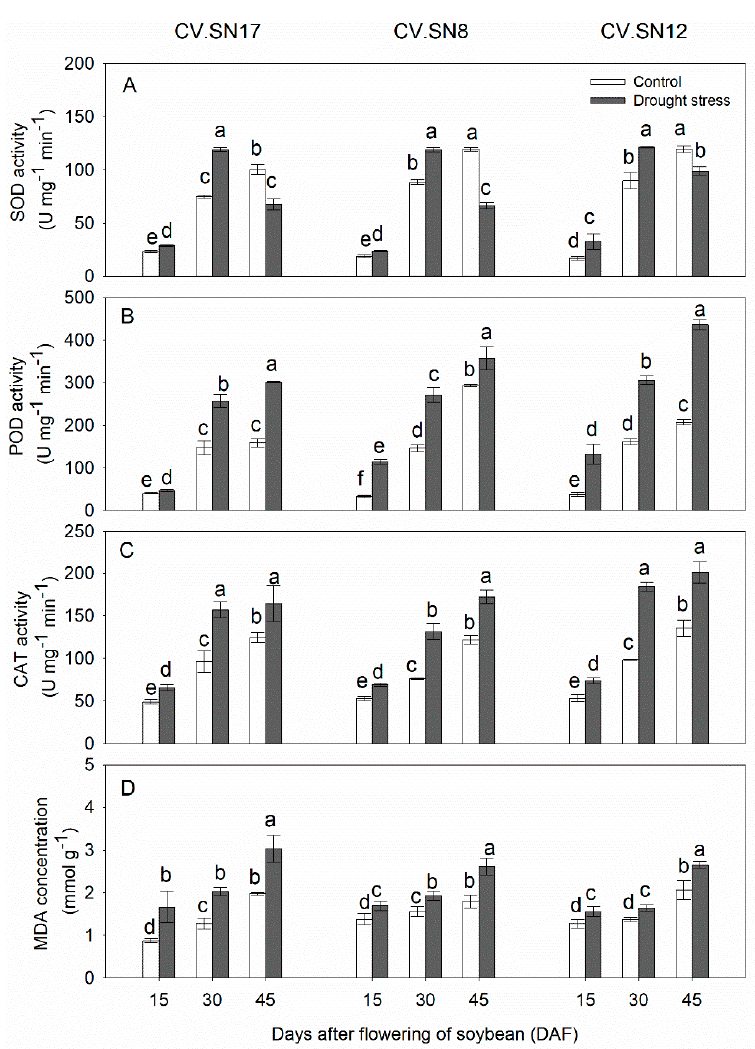
Figure 1. Changes of ( A ) SOD activities, ( B ) POD activities, ( C ) CAT activities and ( D ) MDA concentrations in leaves of CV.SN17, CV.SN8 and CV.SN12 under control and drought stress conditions. Data show the means ± standard deviation of three independent samples. Di ff erent letters above vertical bars indicate significant di ff erences between means at a p < 0.05 level.